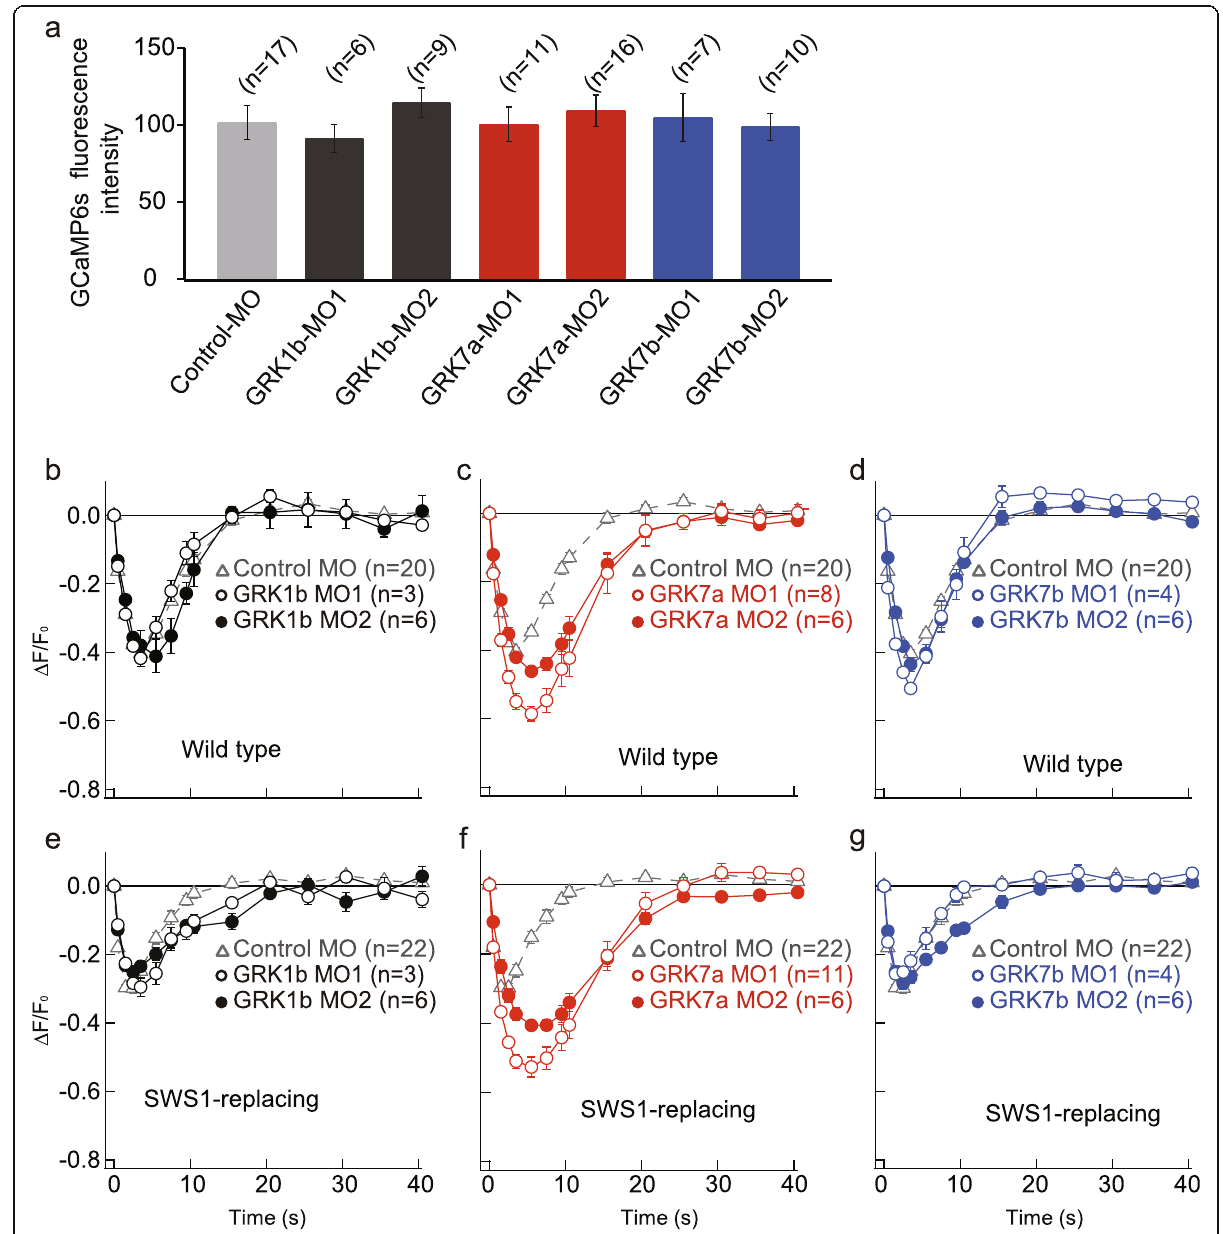
Fig. 2 The light responses of PP1 cells in zebrafish larvae were affected by GRK knockdown. a Quantification of GCaMP6s fluorescence intensity in larvae injected with control MO or one of the GRK MOs. The error bars indicate the standard error. b - g Calcium changes upon 405 nm laser flashes showing the effects of GRK knockdown on light responses in the PP1 cells of wild-type larvae ( b - d ) and SWS1-replacing larvae ( e - g ). b and e GRK1b MO-knockdown larvae. GRK1b-MO1, black open circle; GRK1b-MO2, black closed circle. c and f GRK7a MO-knockdown larvae. GRK7a-MO1, red open circle; GRK7a MO2-knockdown larvae, red closed circle. d and g GRK7b MO-knockdown larvae. GRK7b-MO1, blue open circle; GRK7b-MO2, blue closed circle. Gray open triangles in b-g indicate control MO-injected larvae. The number of animals tested (n) is indicated in parentheses after the MO names in each panel. The error bars indicate the standard error. The duration of each stimulus was ~ 450